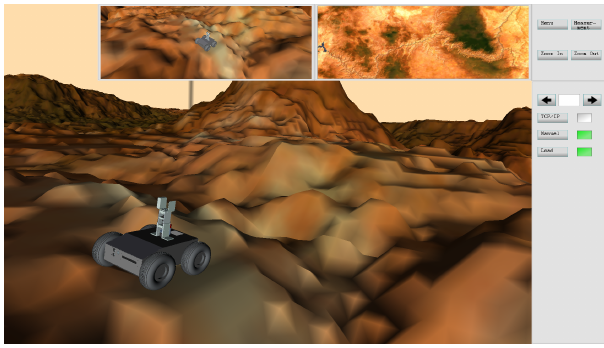
Figure 7: Visualization of OSG-simulation